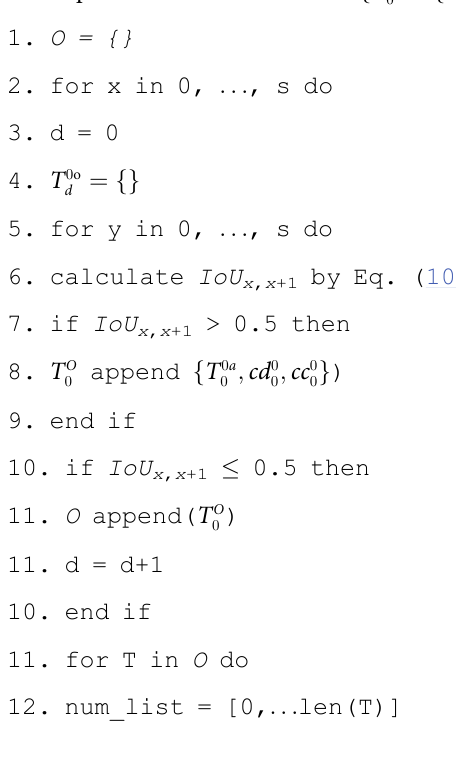
Algorithm 1. Sorting judgment. Input: preliminary